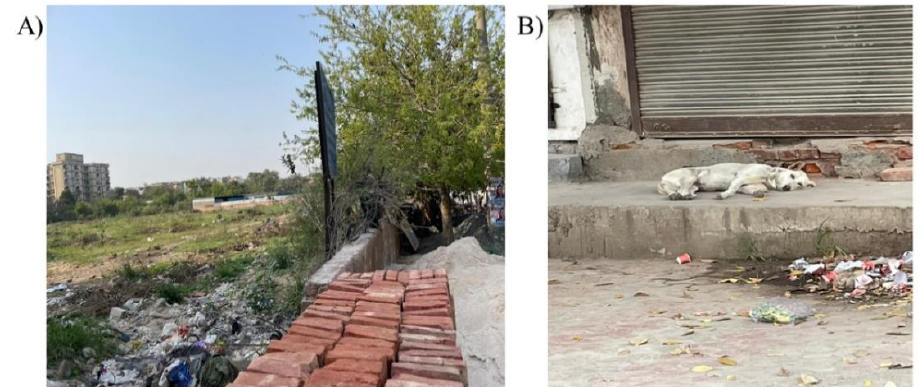
Figure 2. ( A ) Garbage dump in the empty land near the incident site. ( B ) The stray dog which was exposed to the laboratory-confirmed rabid dog during the incident.